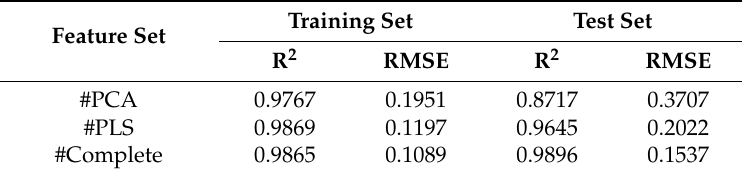
Table 5. Comparison of the #PCA, #PLS, and #Complete parameters combined with the RF model.